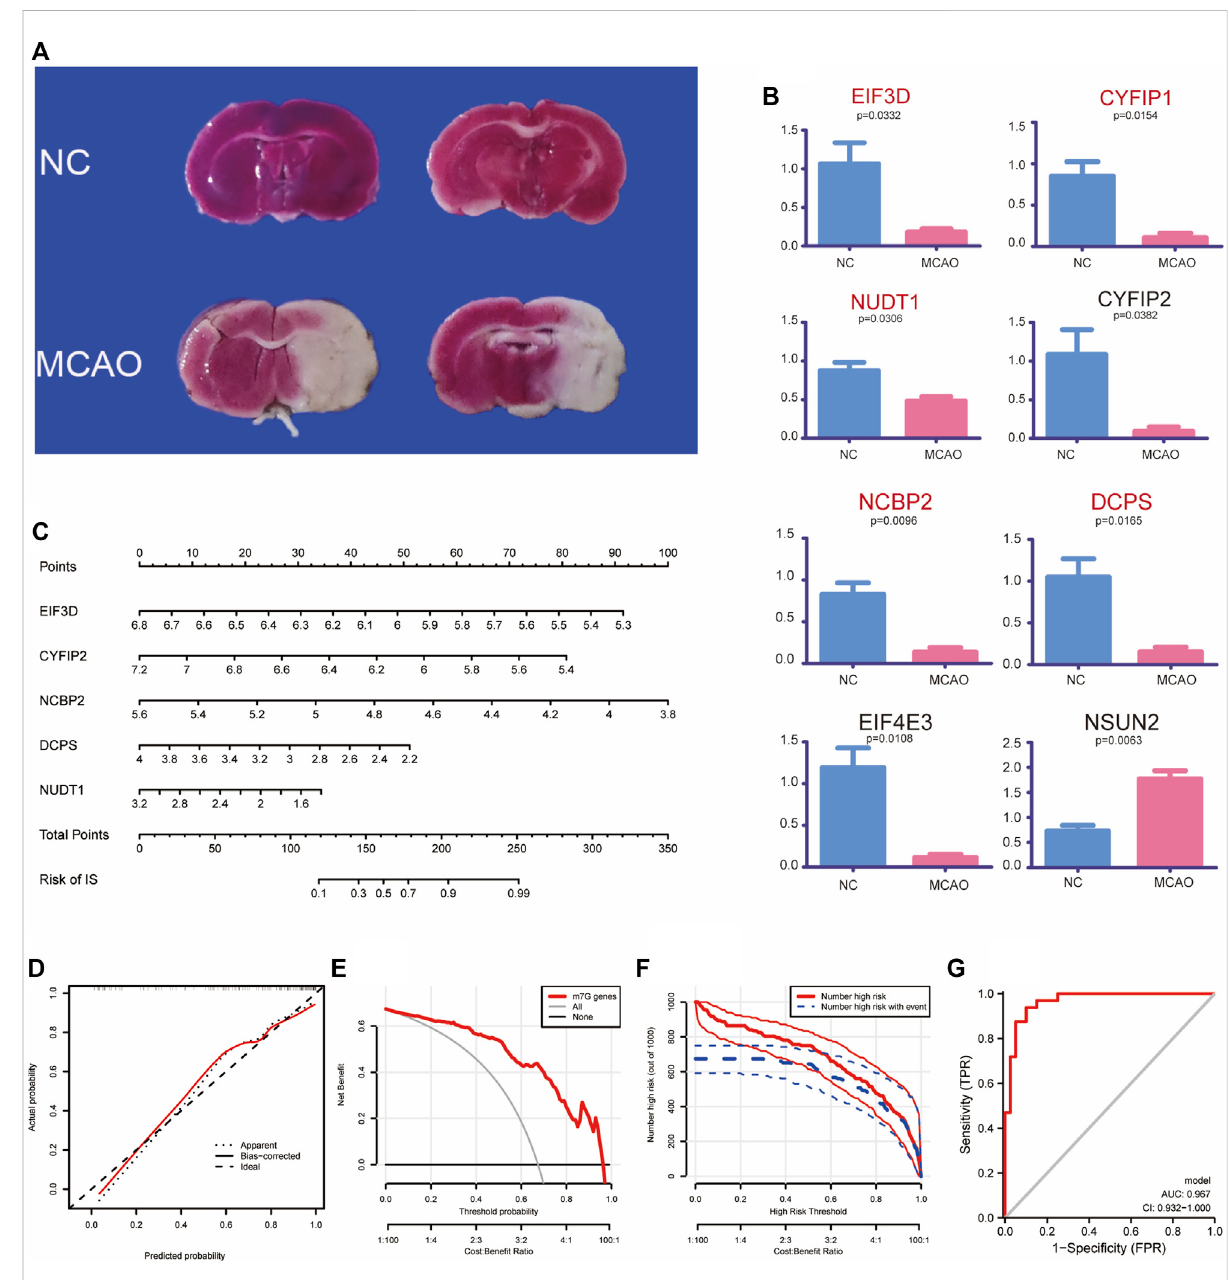
(C) Nomogram of m7G key regulatory genes for predicting IS. Calibration curve (D) , Clinical decision analysis (E,F) and ROC curve (G) of nomogram. TTC: 2, 3, 5-triphenyl tetrazolium chloride; MCAO: middle cerebral artery occlusion; IS: ischemia stroke; ROC: receiver operating